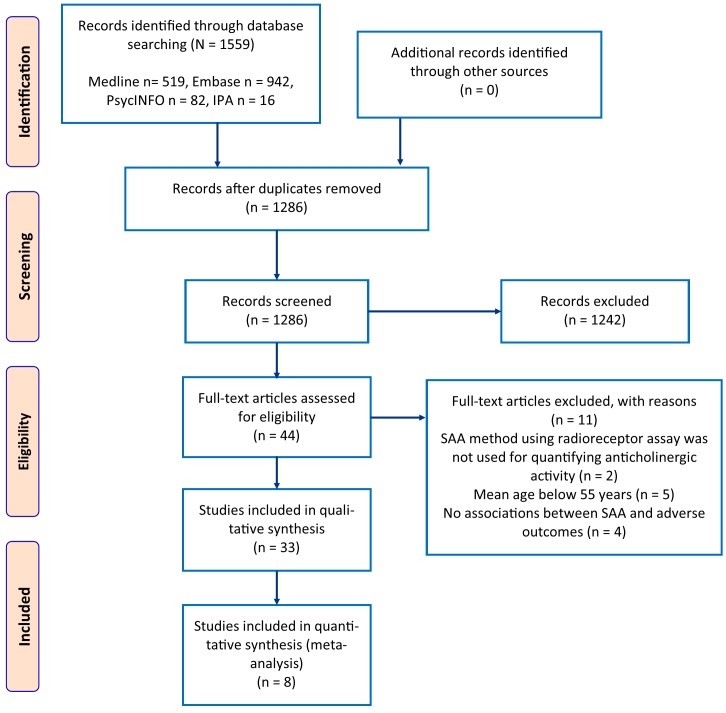
PRISMA flow diagram of study selection process.